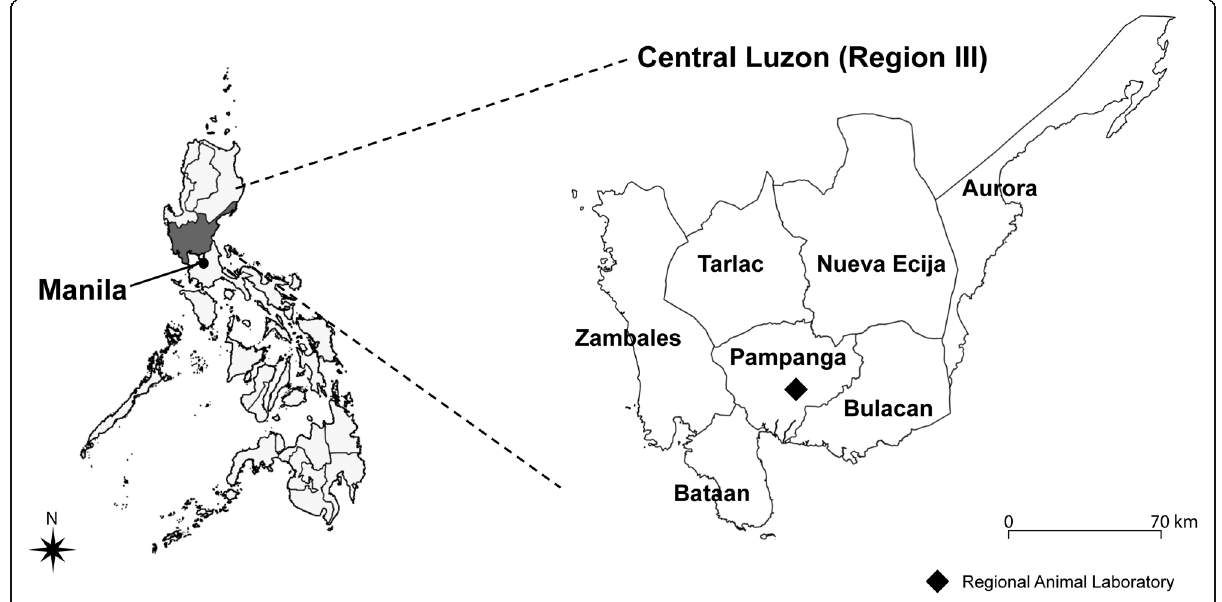
Fig. 1 Map depicting the locations of Region III in the Philippines and Regional Animal